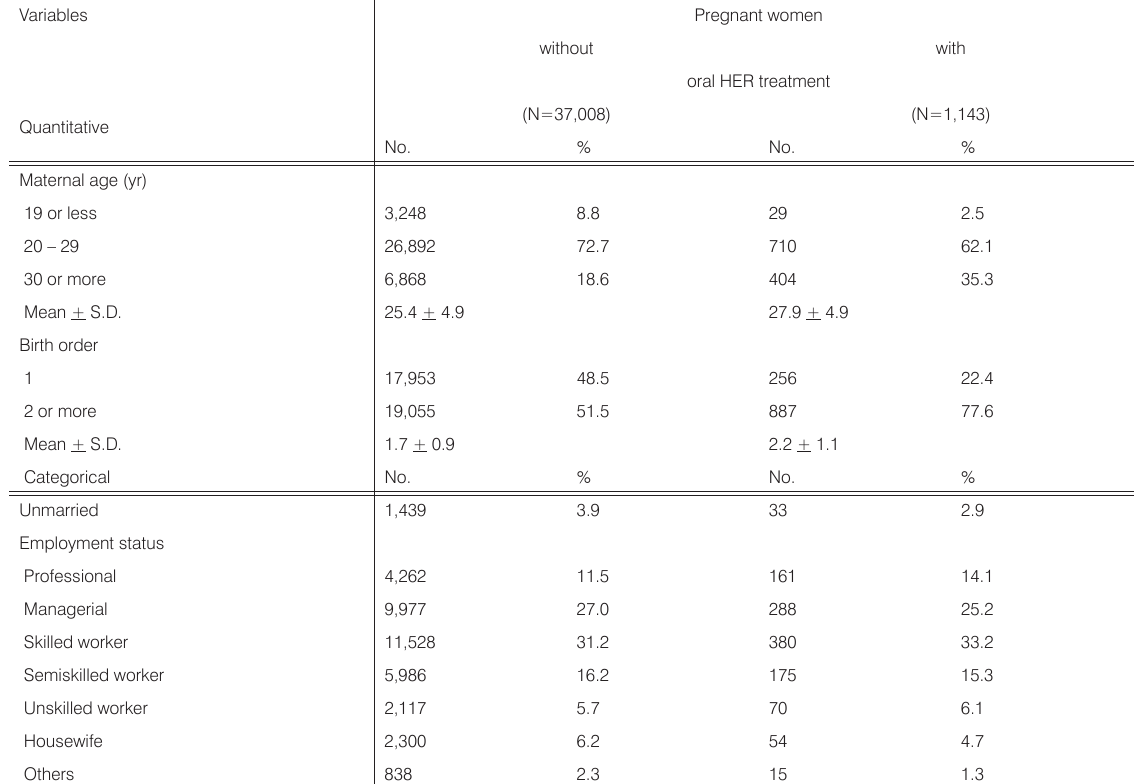
Table 1. Maternal characteristics of pregnant women with oral HER treatment and without HER treatment as reference